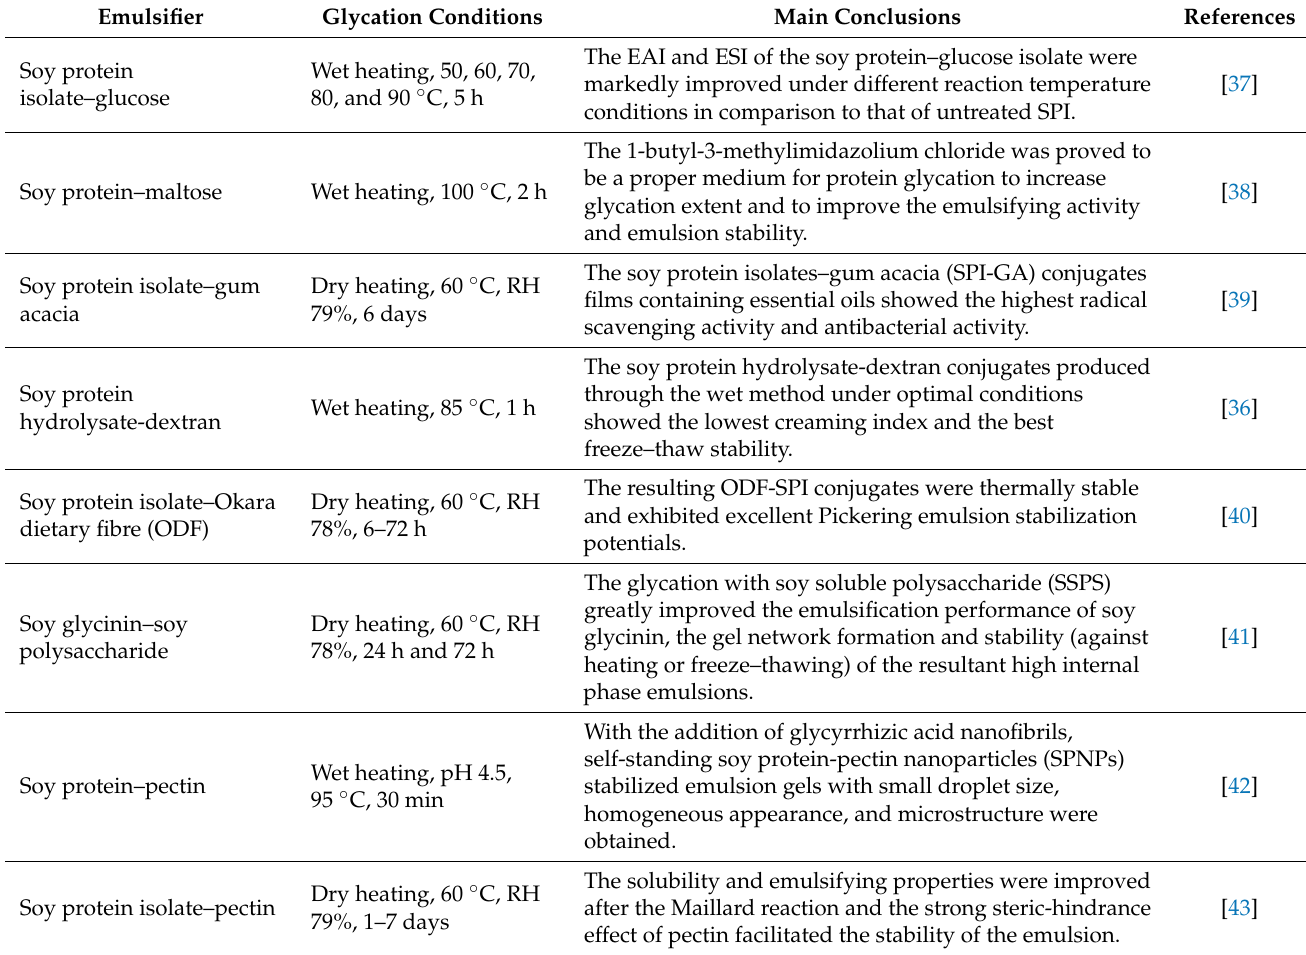
Table 1. Lists of recently reported studies focusing on polysaccharide glycation with soy proteins for improved emulsifying